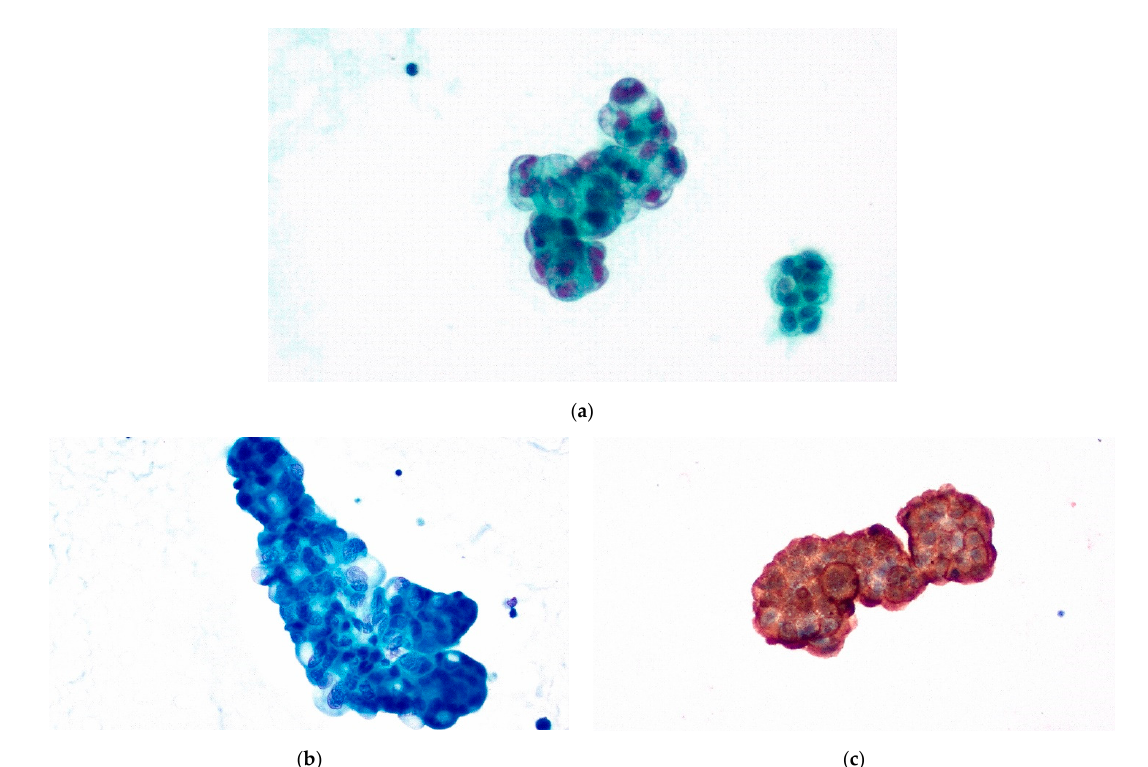
Figure 3. Peritoneal effusion, MAL (TIS5), pancreatic adenocarcinoma. ( a ) Pap stain ×400, ( b ) Giemsa stain ×400 and ( c ) CEA immunostain ×400.